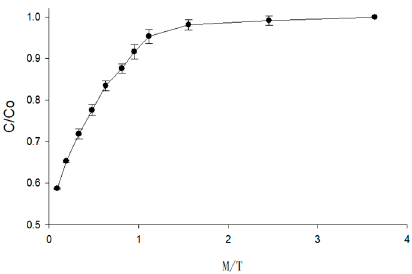
Figure 8. The changes of the anthocyanin retention ratio of berry puree with the M / T